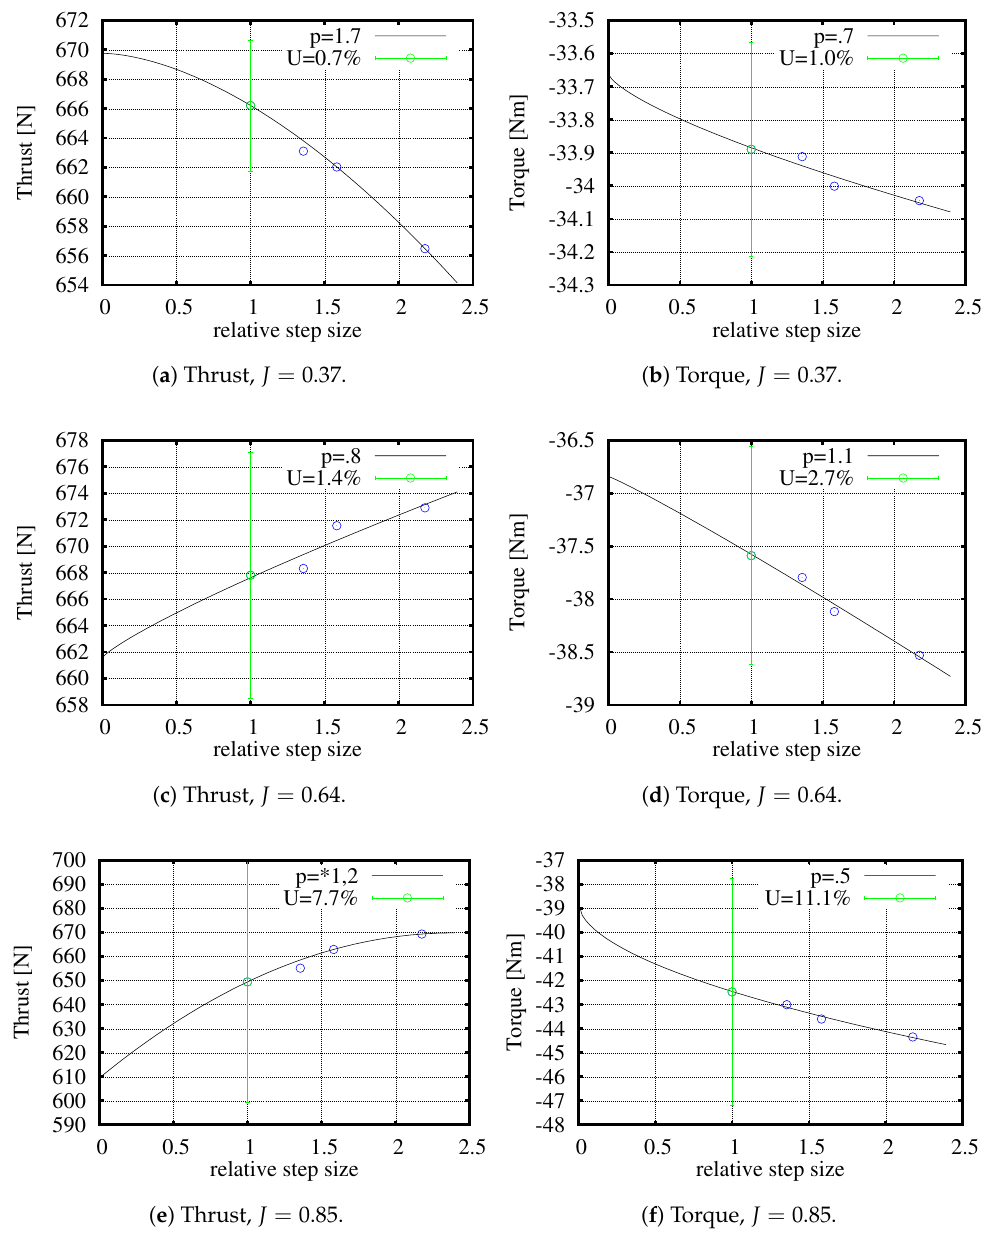
Figure 2. Numerical uncertainty of thrust and torque, U and order of accuracy p for various advance